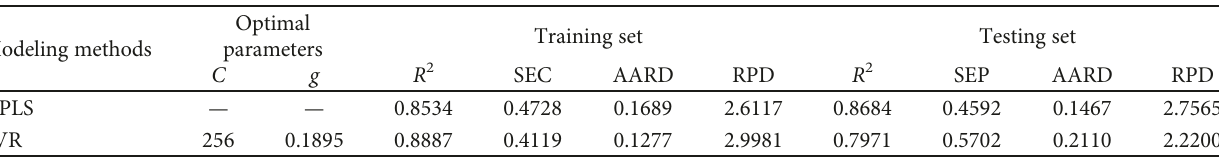
Table 6: The results of the optimal models for quanti fi cation of the relative content of Pst DNA in wheat leaves in the incubation period built using individual methods including QPLS and